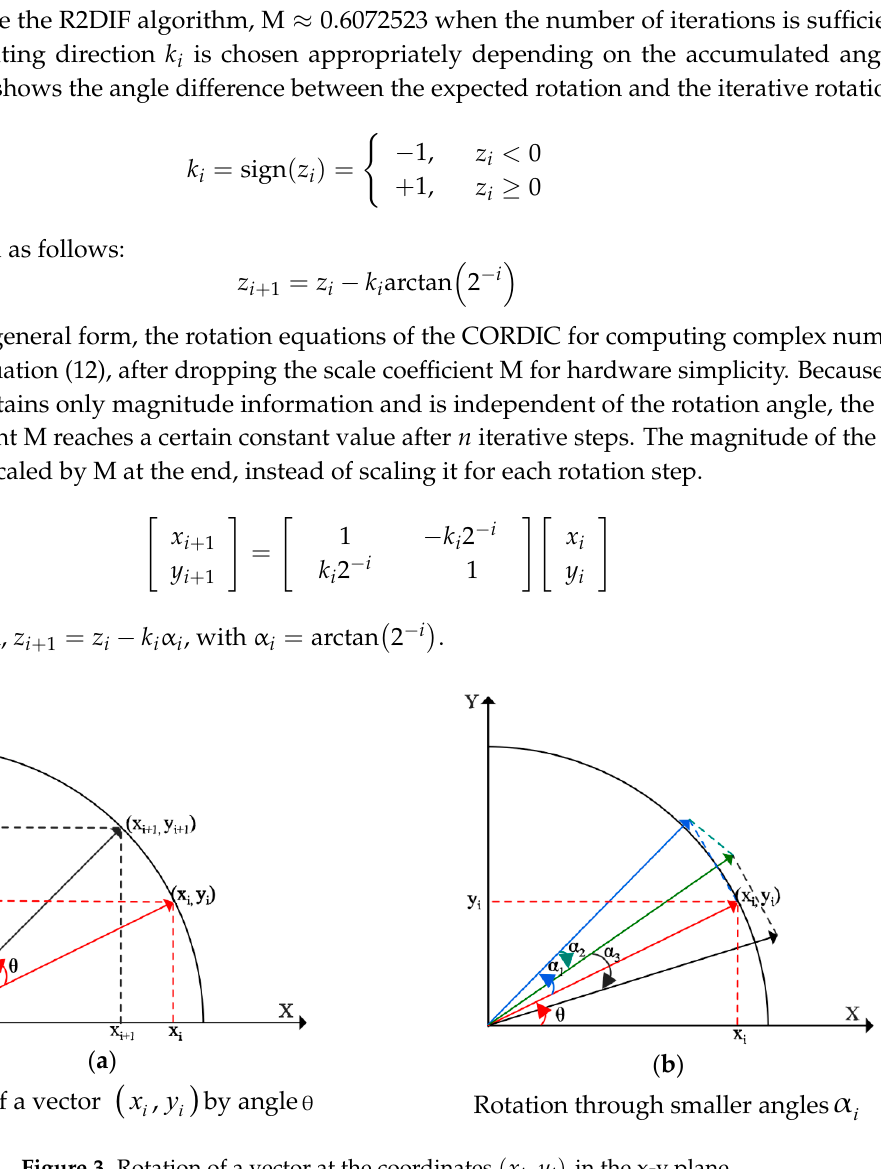
Figure 3. Rotation of a vector at the coordinates